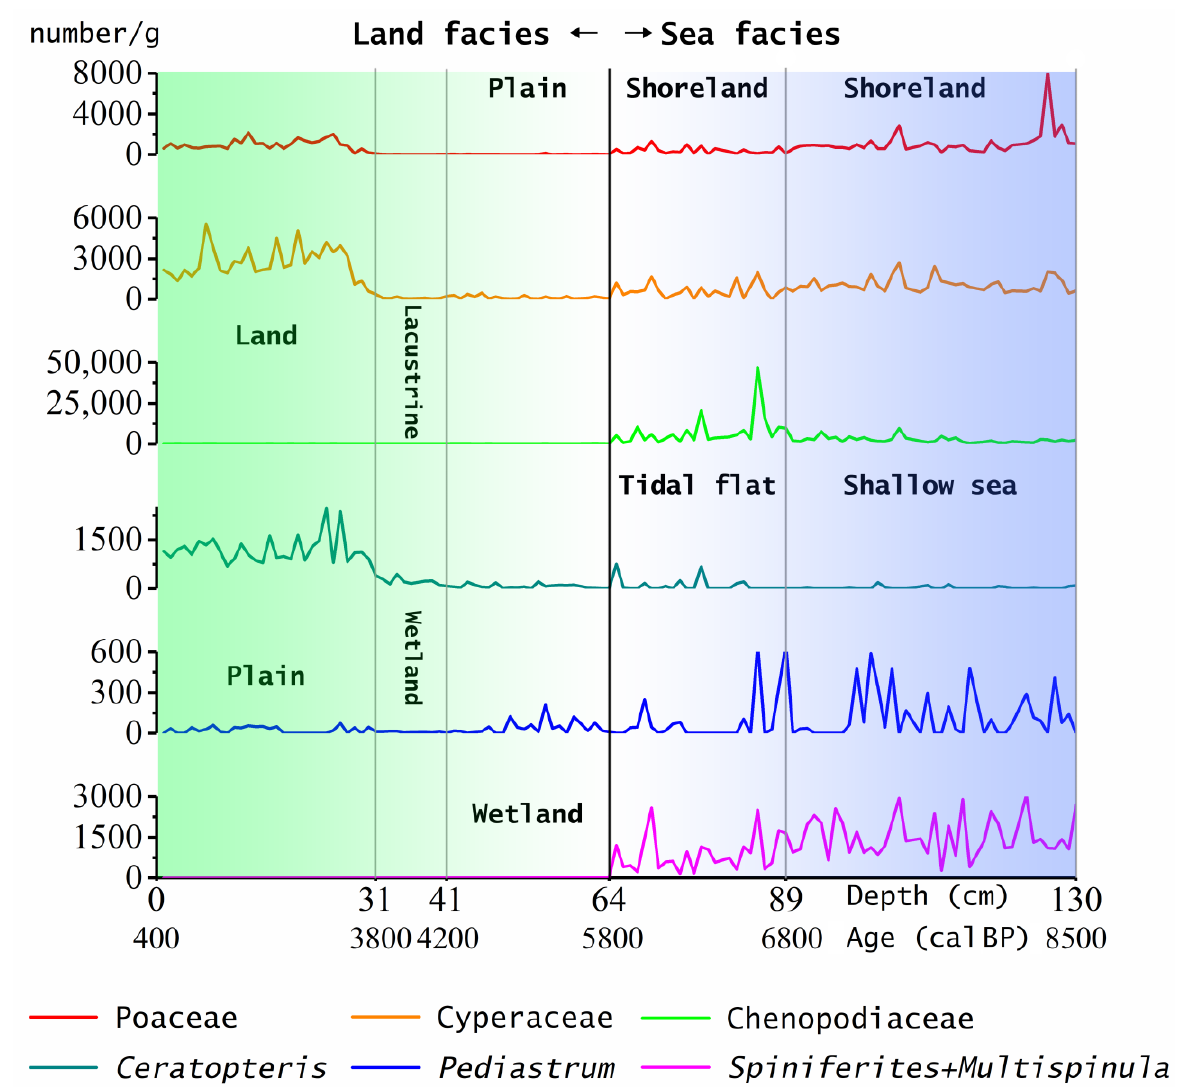
Figure 5. Pollen concentration of some aquatic algae and terrestrial herbs of the GX2 section and geomorphic evolution.